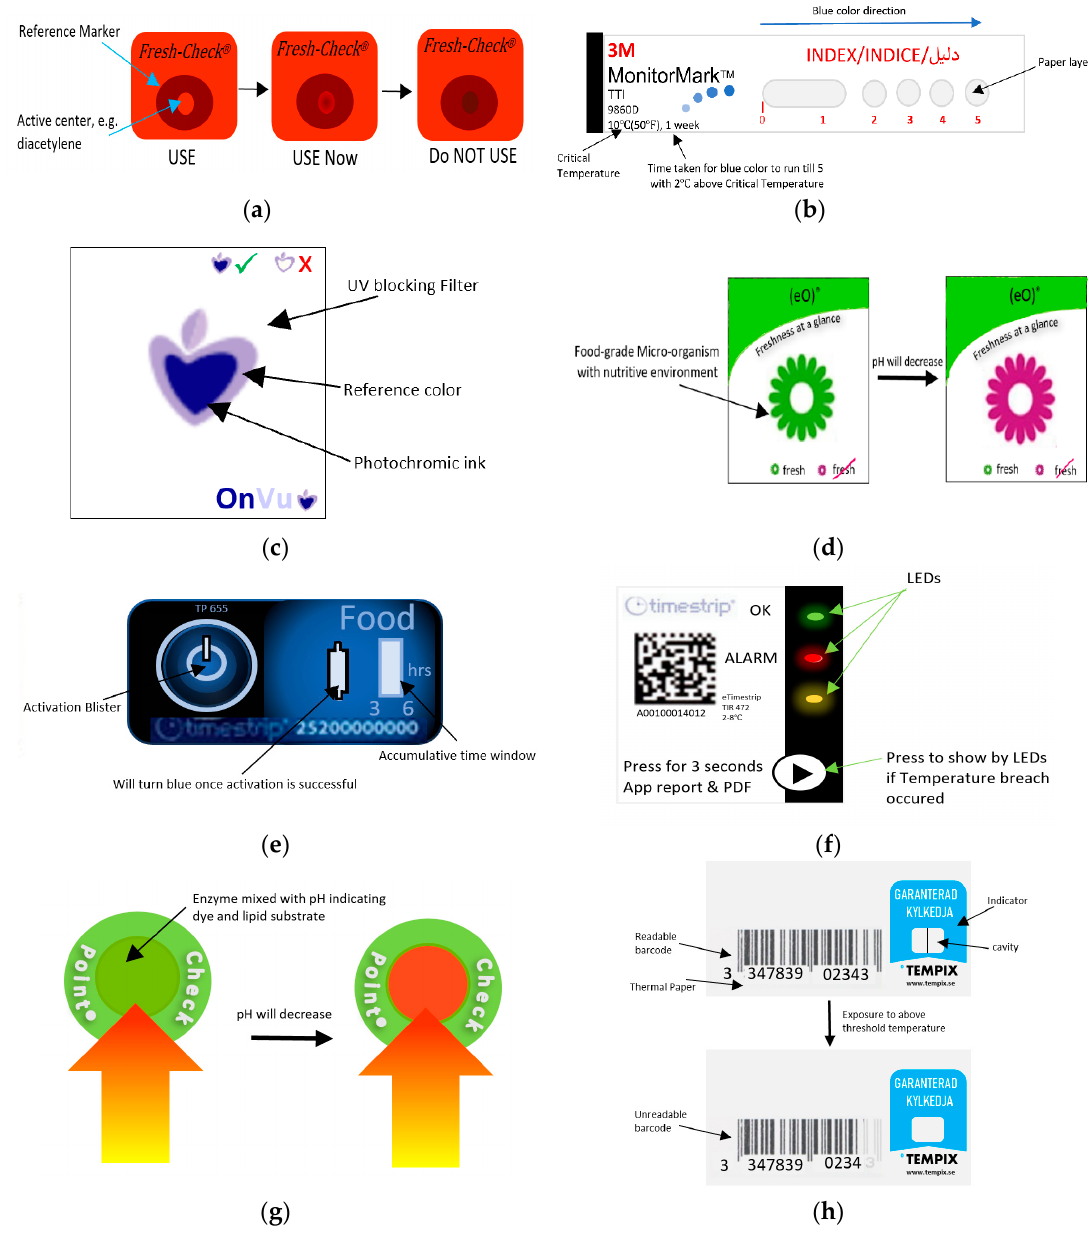
Figure 14. ( a ) Fresh-Check ® indicator. ( b ) Monitor Mark indicator. ( c ) Time-temperature effect on OnVu TM indicator. ( d ) eO ® indicator. ( e ) Timestrip ® indicator. ( f ) eTimestrip ® indicator. ( g ) Checkpoint ® indicator. ( h ) Tempix ® indicator.